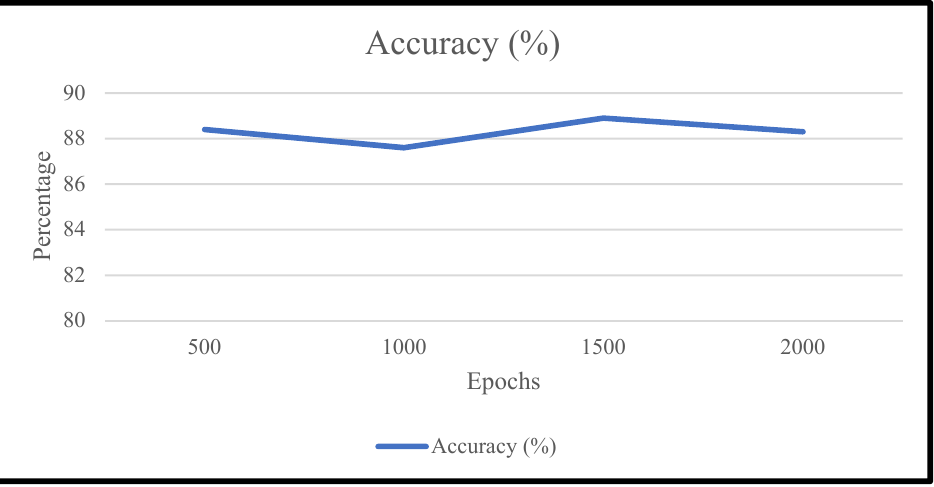
Figure 9. Comparison of results on various epochs.